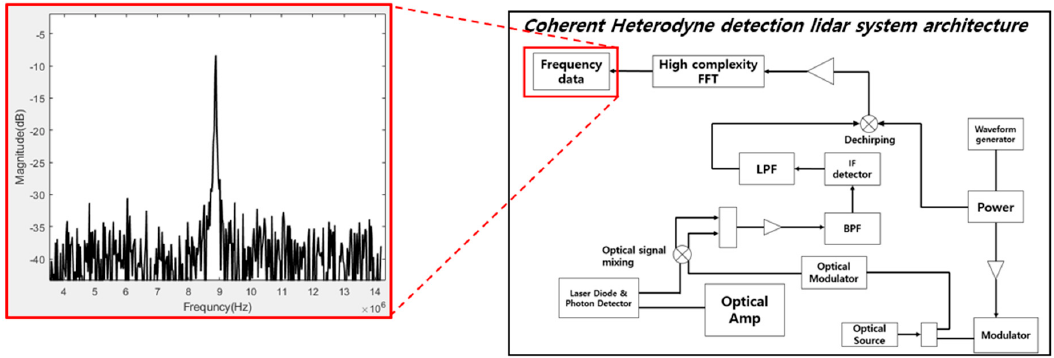
Figure 1. Traditional Coherent Heterodyne Detection FMCW LiDAR Architecture.